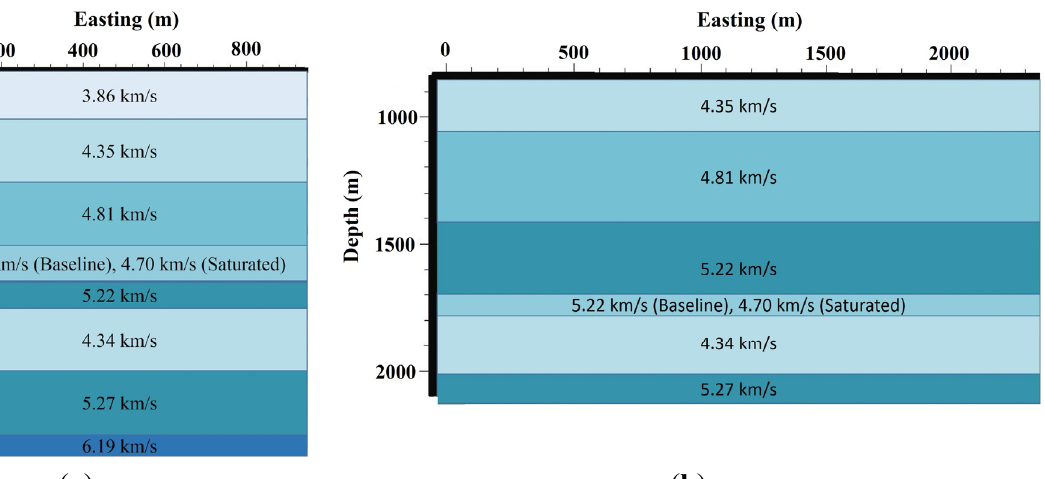
Figure 6. ( a ) Cross section of the initial velocity model for the first synthetic test using a random distribution of 1000 events. Eight receivers are placed on the vertexes of the cube and 42 are distributed randomly throughout the rest of the cubic velocity model. And ( b ) Cross section of the initial velocity model for the second synthetic test using the Aneth event and receiver